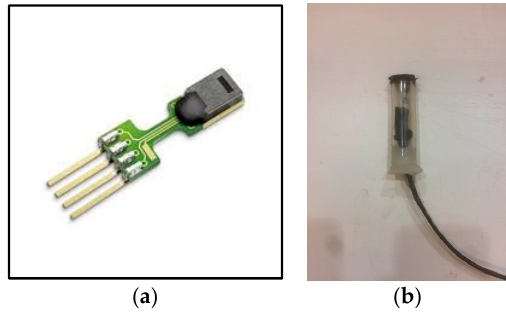
Figure 3. SHT75 Sensirion humidity and temperature sensor after treatment.